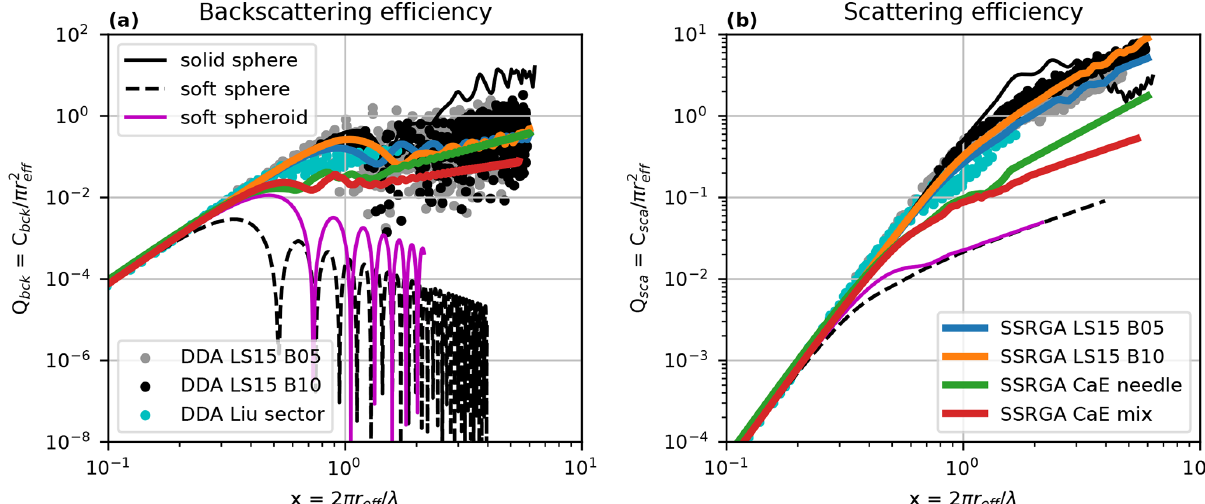
Figure 5. Comparison of commonly used scattering methods for snowflakes in terms of backscattering (a) and extinction (b) efficiencies. Efficiency is defined as Q = C/πr 2 , with the effective radius r eff being the radius of an equal-mass ice sphere and C the corresponding eff (backscattering or extinction) cross section. Scattering efficiencies are plotted against the size parameter defined with respect to the effective radius x = 2 πr eff /λ . This representation allows us to combine the dependence of scattering with respect to both the mass of the particle and the electromagnetic wavelength. The soft-sphere and soft-spheroid (aspect ratio equals 0.6) approximations are obtained by assuming a mass–size relation following Brown and Francis (1995) and give the smallest scattering efficiency among the presented methods. The solid sphere generally gives the largest scattering response. DDA results are plotted from published databases for partially rimed (Leinonen and Szyrmer, 2015) aggregates and the sector snowflake of Liu (2008). The SSRGA computations obtained from some of the unrimed and rimed aggregates included in snowScatt are overplotted for